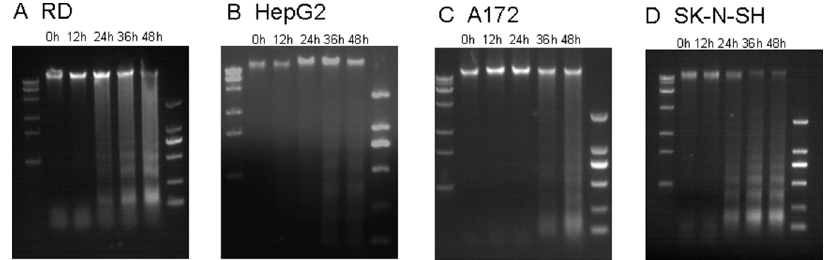
Figure 3. CA16 infection induces DNA fragmentation. (A) RD, (B) HepG2, (C) A172 and (D) SK-NSH cell lines were infected with CA16 SHZH05 virus at the MOI of 0.2, 0.2, 0.2 and 0.05, respectively, and collected at 0 h, 12 h, 24 h, 36 h or 48 h as indicated. DNA was extracted from cells and analyzed for fragmentation via agarose gel electrophoresis. Representative images are shown of three individual experiments (n=3) performed for each cell line.